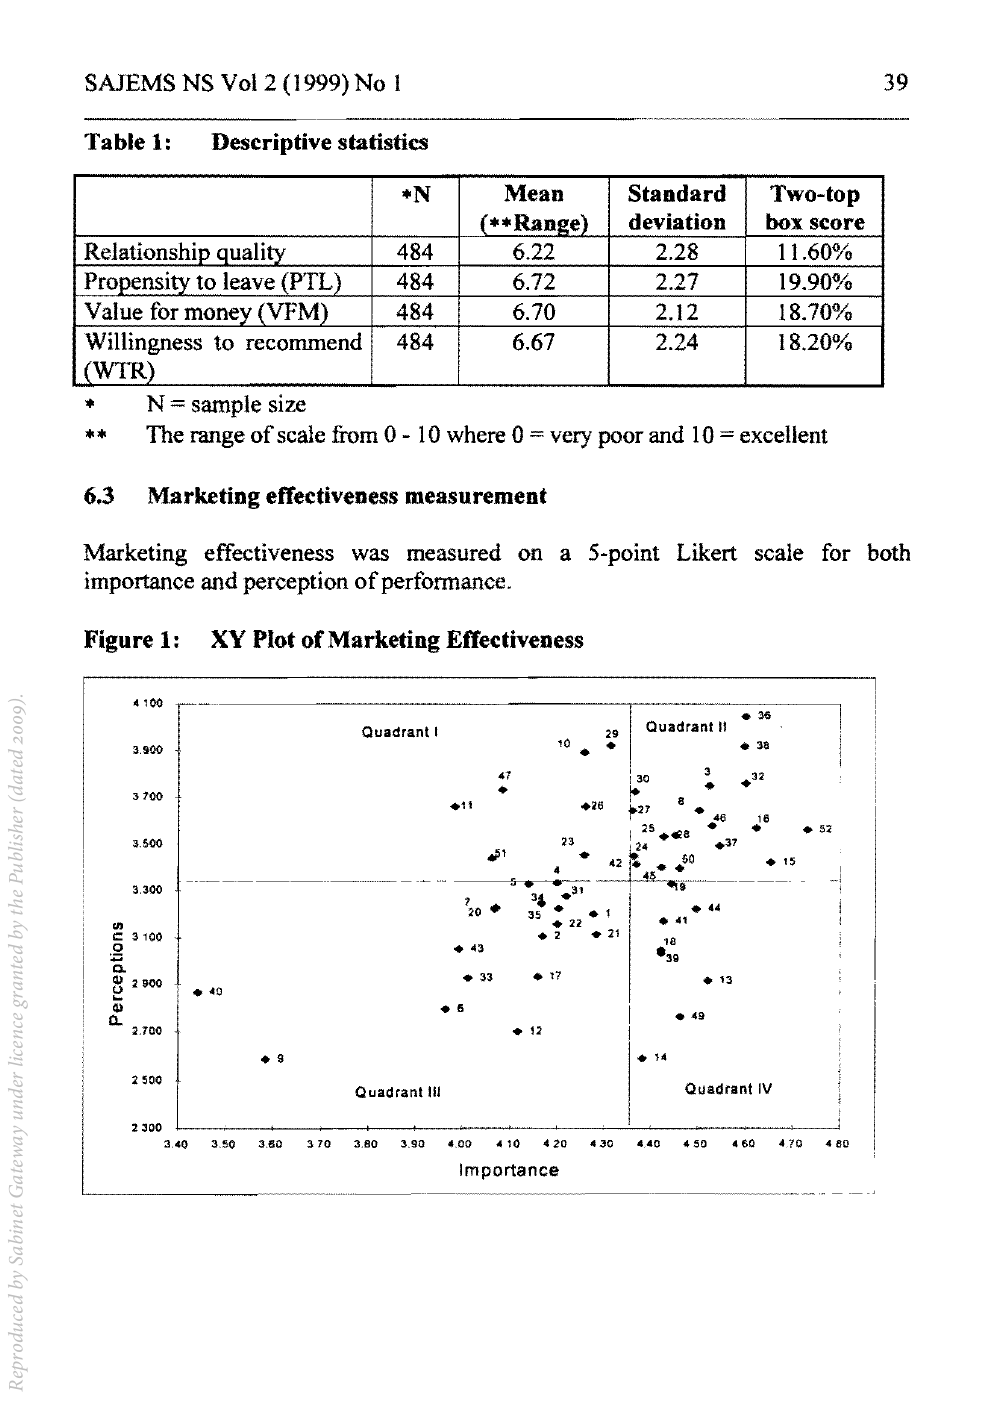
Descriptive statistics